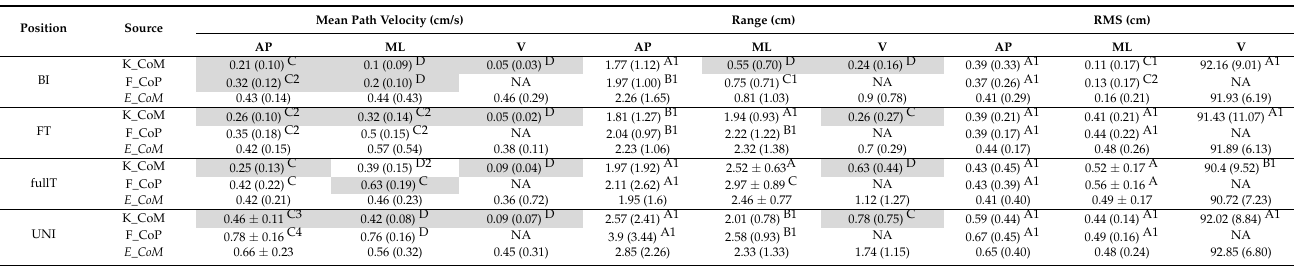
Table 4. Descriptive and reliability statistical results for the one-dimension parameters for the comparison between Equimetrix CoM ( E _ CoM ) and the kinematic CoM (K_CoM) and force platform CoP (F_CoP) for the anterior–posterior (AP), medial–lateral (ML) and vertical (V) components. Parametric data is expressed as Mean ± Standard-deviation, while non-parametric data is express as Median (Inter-quartile range).